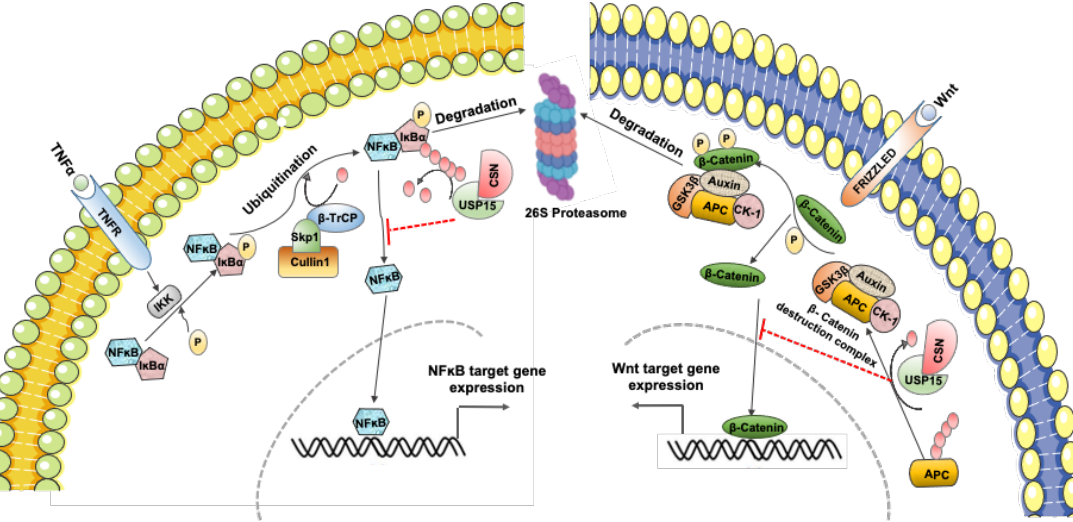
Figure 2. USP15 suppresses TNFα and Wnt signaling in association with CSN. Upon stimulation by TNFα, NF-ĸB is activated through phosphorylation and ubiquitin-dependent degradation of IĸB by CRL/SCF βTrCP E3 ubiquitin ligase to turn on its downstream target genes. USP15, in association with CSN, deubiquitinates and promotes IĸB stabilization by inhibiting CRL/SCF βTrCP activity and hinders NF-ĸB signaling ( left ) [33]. USP15 negatively regulates Wnt/β-catenin signaling by promoting the formation of the β-catenin destruction complex. In association with CSN, USP15 deubiquitinates and induces the stability of the essential component of the β-catenin destruction complex APC, which is required to target the phosphorylated β-catenin for CRLβ-TrCP-dependent proteasomal degradation ( right ) [35].